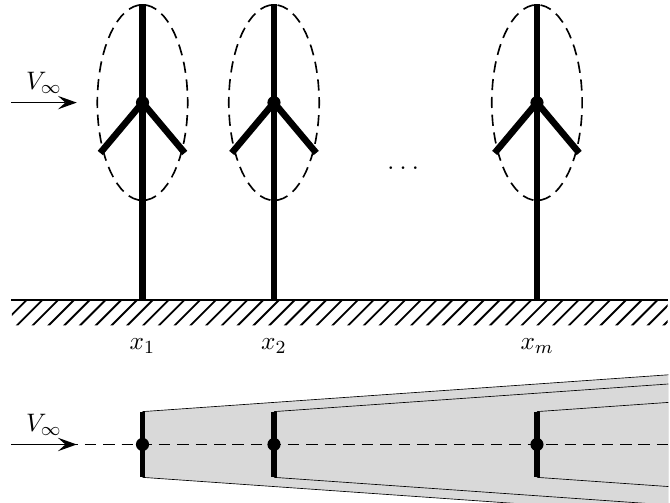
Figure 1. Example of wind farm layout and the corresponding wake